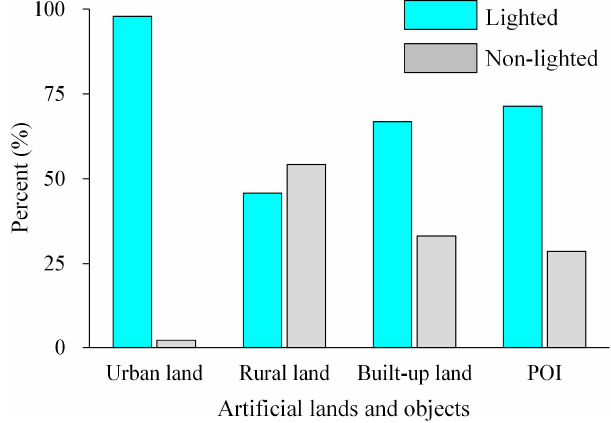
Figure 3. The percentage of lighted and non-lighted pixels for three types of artificial land and POIs at the pixel level across China in